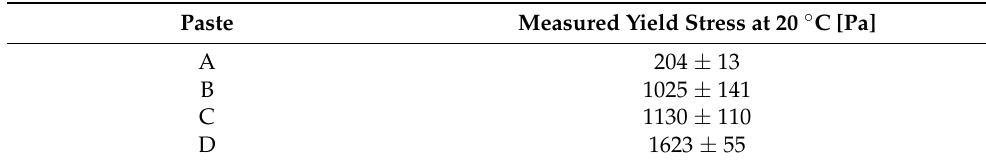
Table 3. Yield stress of four silver pastes modified for